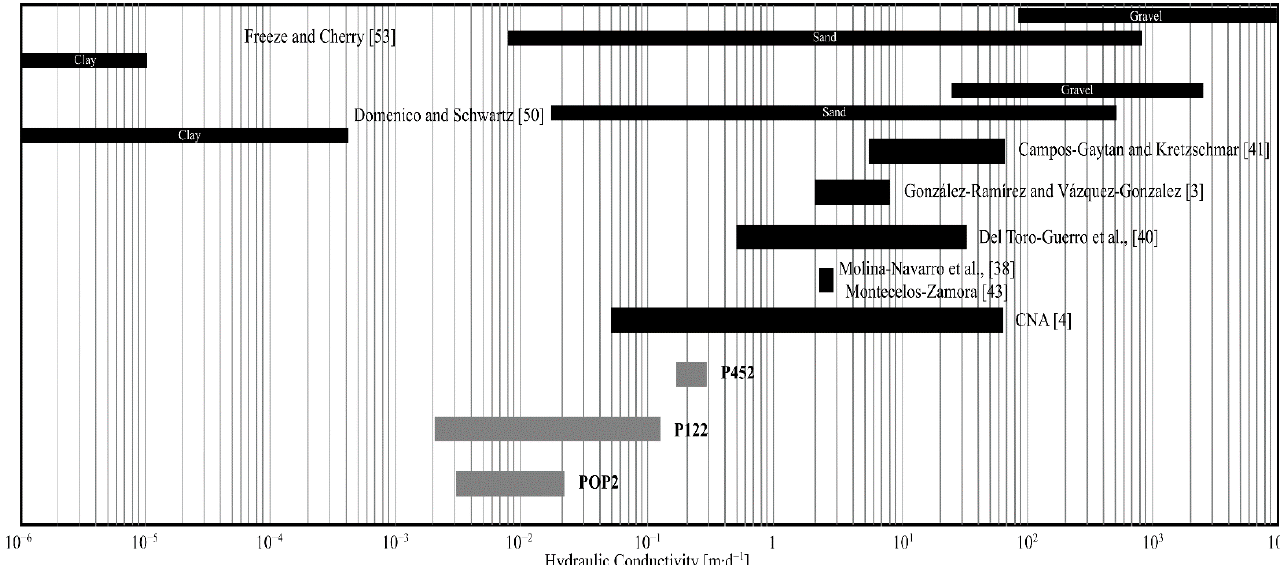
Figure 6. Comparison between the estimated hydraulic-conductivity values (P452, P122, and POP2) and the expected values as a function of the rock-material type, and determined values from previous studies.